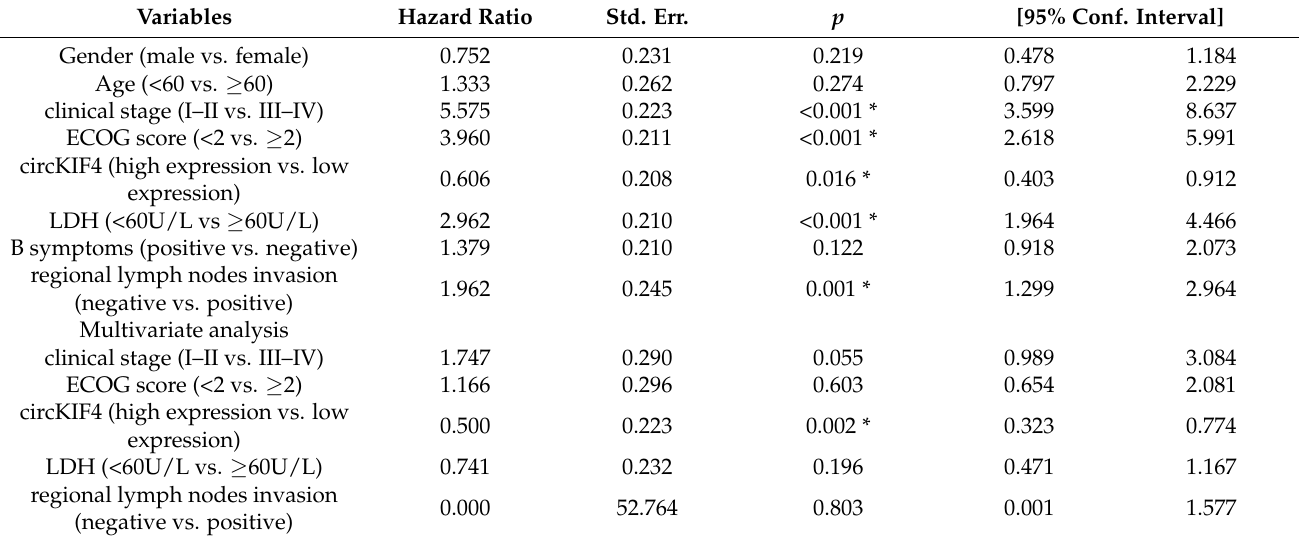
Table 1. Univariate and multivariate COX analysis of OS in NKTL